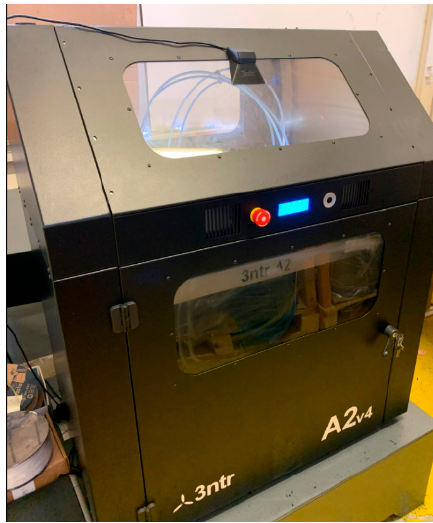
Figure 1. Picture of the 3D printer A2V4 from 3ntr.